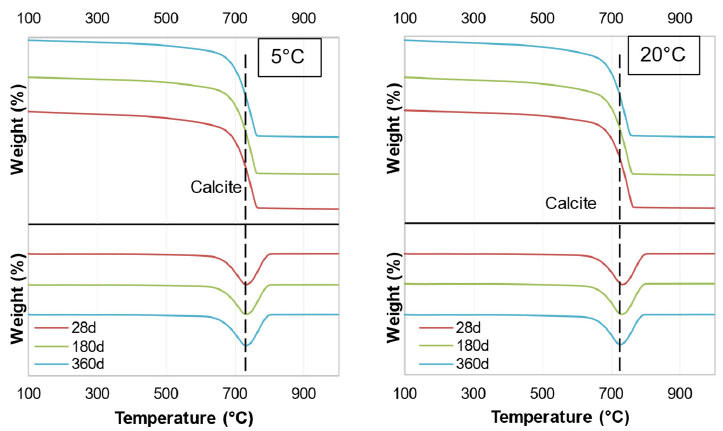
Figure A5. TGA results in S + F + W1.